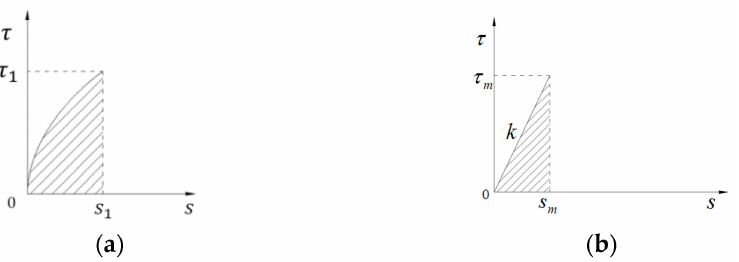
Figure 5. Bond–slip linear model transformation. ( a ) Actual bond–slip model and ( b ) linear bond–slip